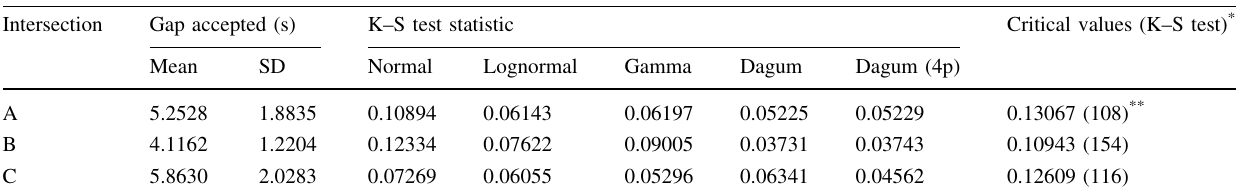
Table 3 Statistical parameters for accepting gap distribution